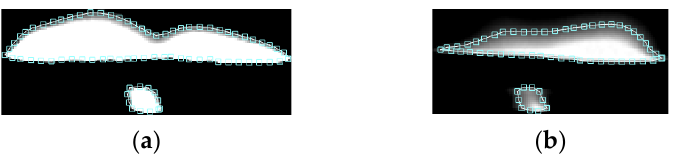
Figure 8. Assigned contours of the cropped ROIs from Figure 7 for calculating the plume area: ( a ) left direction of view; ( b ) right direction of view.